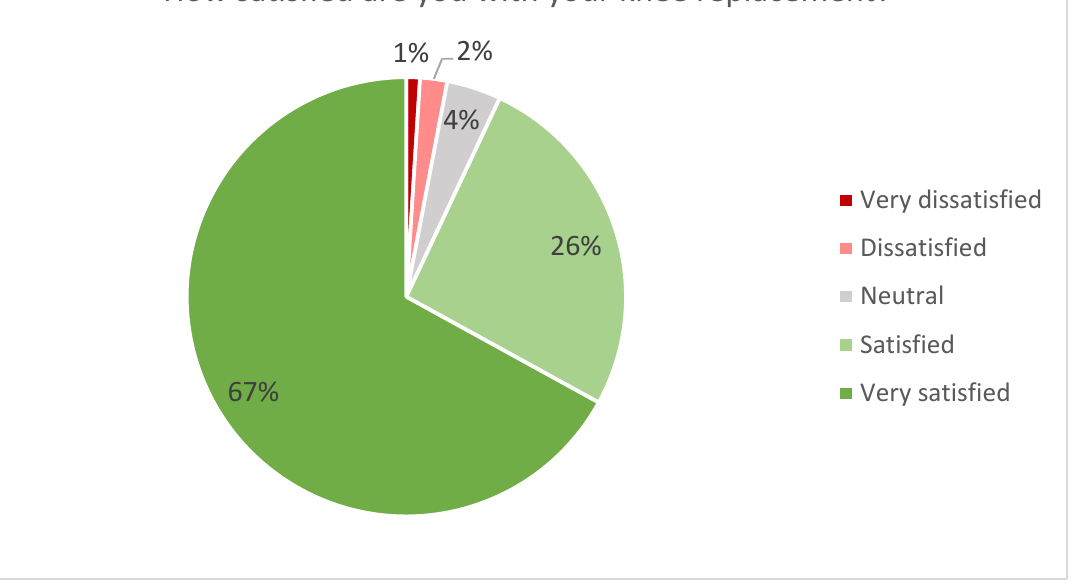
Figure 2. Patient satisfaction with C-UKA.